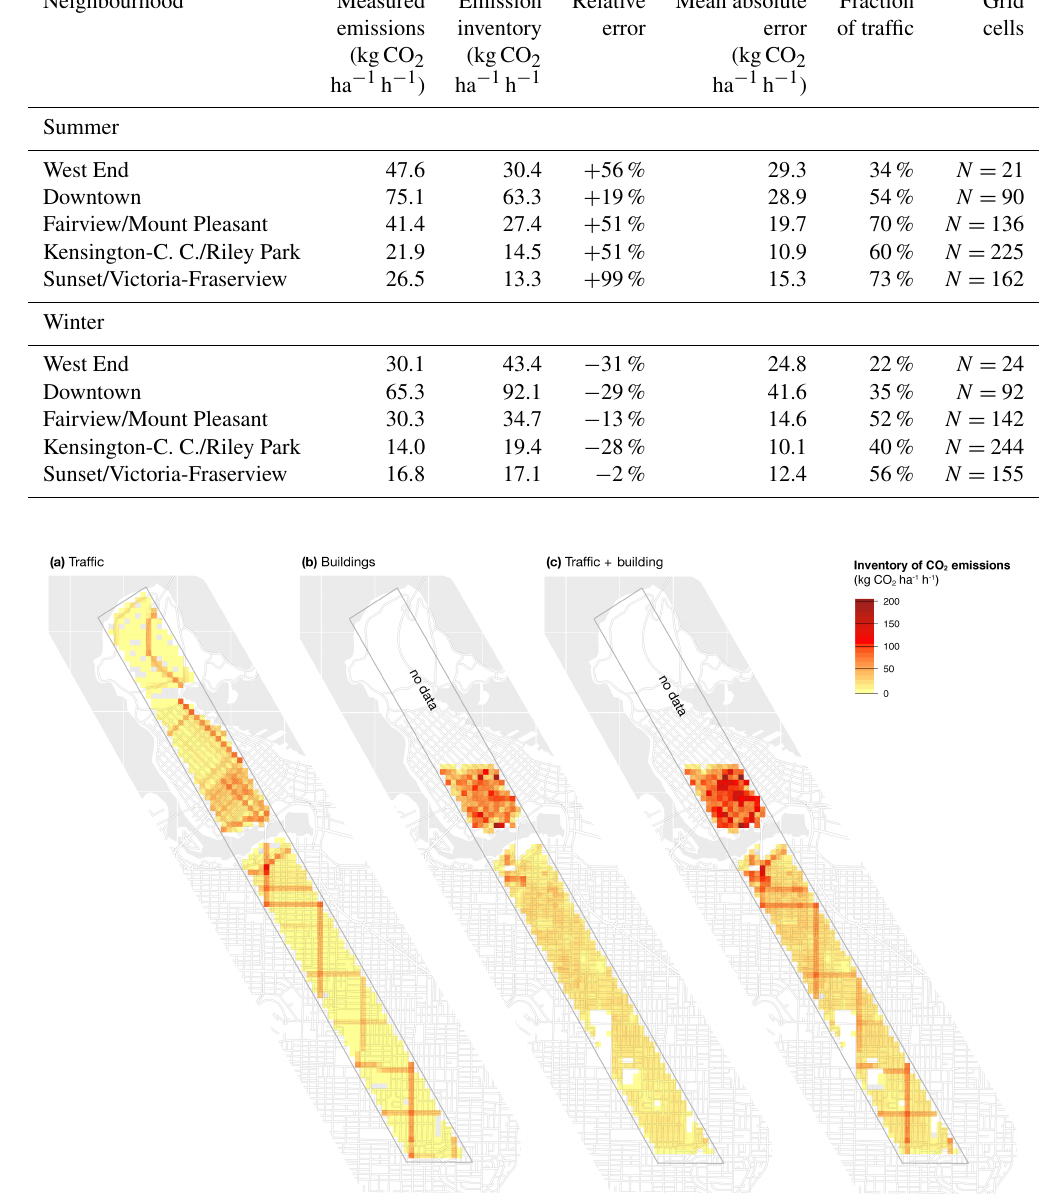
Figure 7. Emission inventory for (a) traffic emissions, (b) local building sector emissions, and (c) total (traffic + buildings) emissions for the time of the winter campaign. The equivalent emission inventory for the summer date (not shown) does not look significantly different, but it has overall lower building emissions. Note that the building inventory, available from a previous study, did not extend into the northern part of the transect (label “no data”) due to lack of high-resolution lidar data in this part of the city.